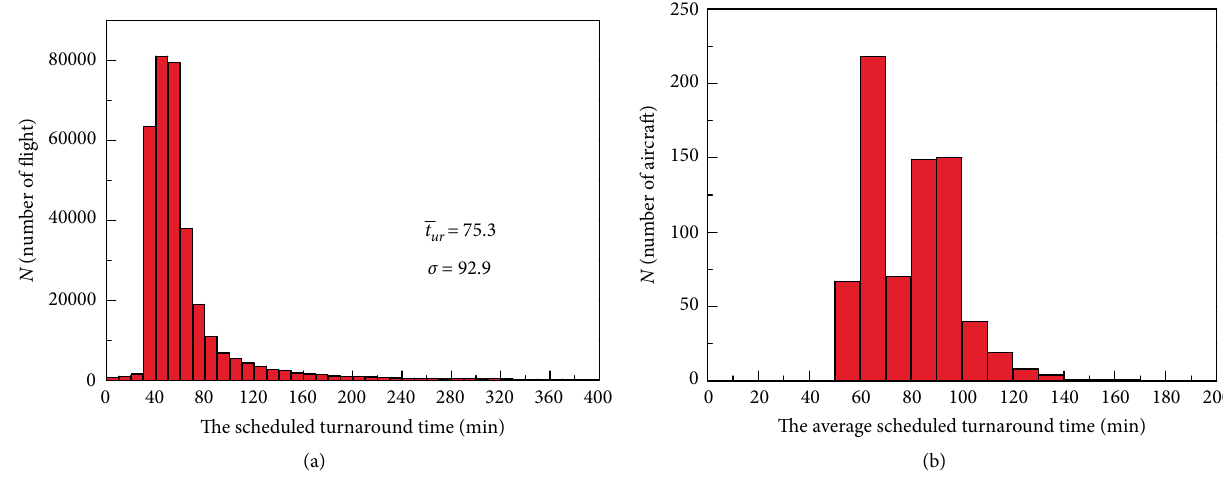
Figure 4: (a) Number distribution of the schedule turnaround time for 347073 flights. (b) Number distribution of the average schedule turnaround time for a total of 728